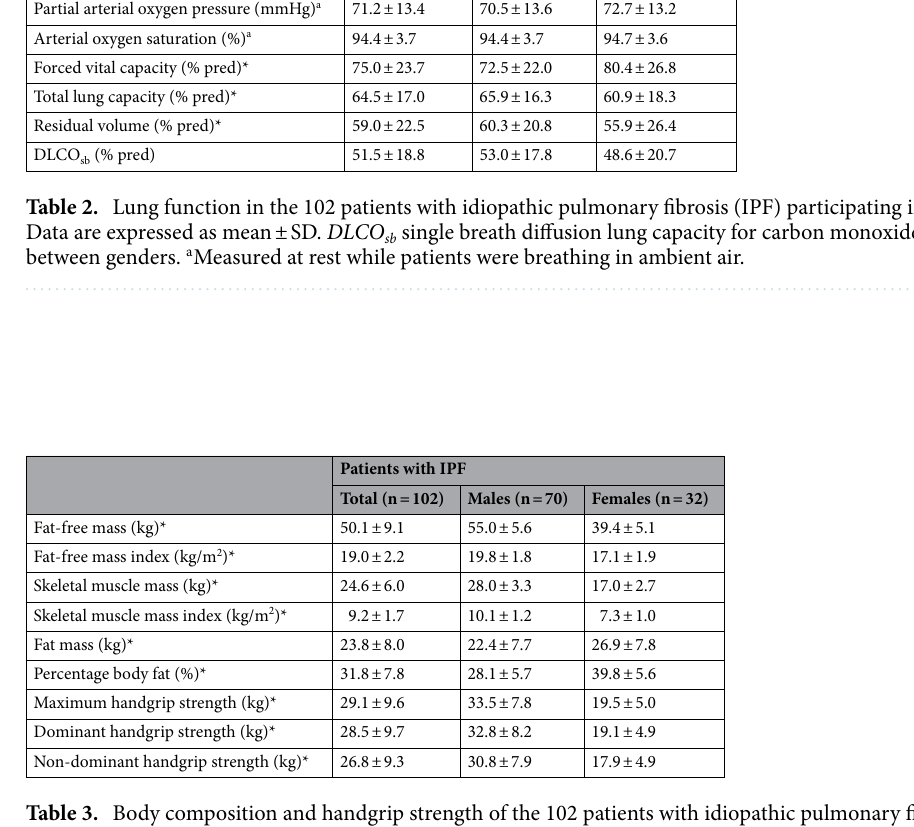
Table 3. Body composition and handgrip strength of the 102 patients with idiopathic pulmonary fibrosis (IPF) participating in the study. Data are expressed as mean ± SD. * p < 0.05 between genders.